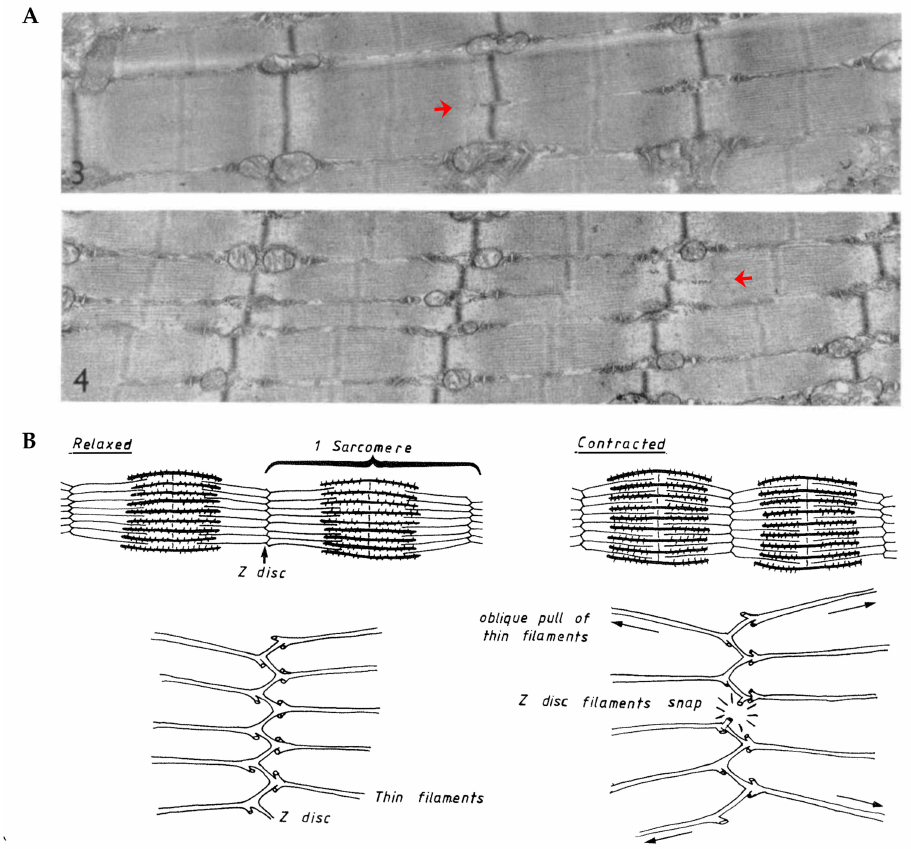
Figure 8. ( A ) Electron micrographs of longitudinal sections from mouse skeletal muscle. Red arrows highlight myofibrils that appear to split into two smaller daughter myofibrils (copied with permission from [186]). ( B ) Illustration from Goldspink (1983) which describes how the oblique angle of the thin myofilaments could exert outward radial forces on the Z-disc when the sarcomeres contract (copied with permission from